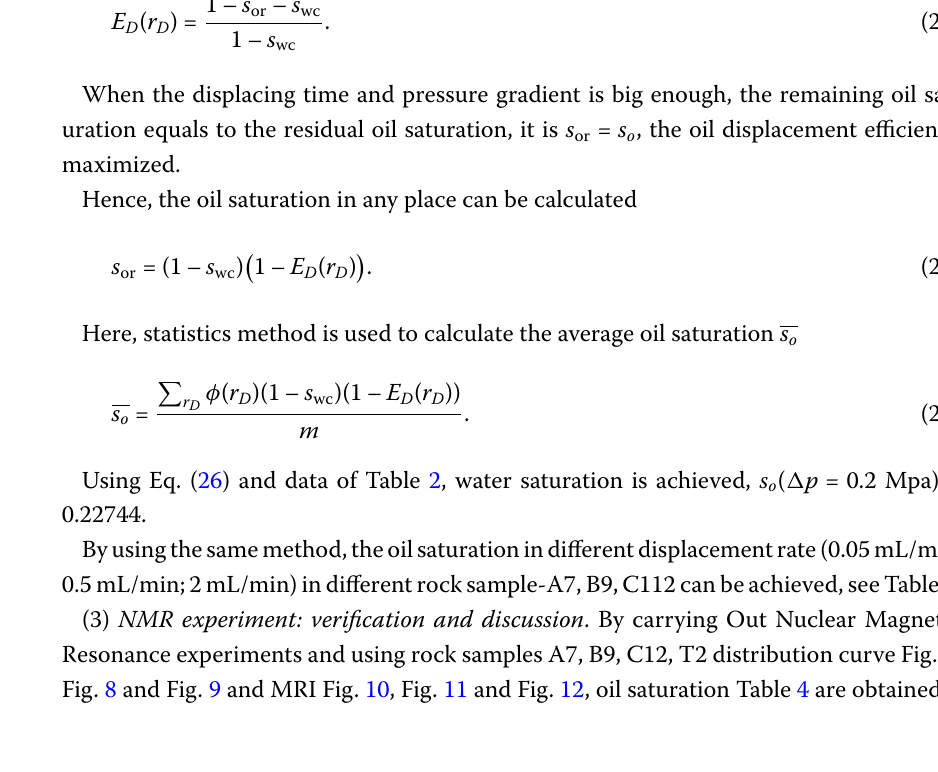
and when R = 5 m, r D = 6.465 μ m, the oil displacement efficiency is near to 0.937788 in